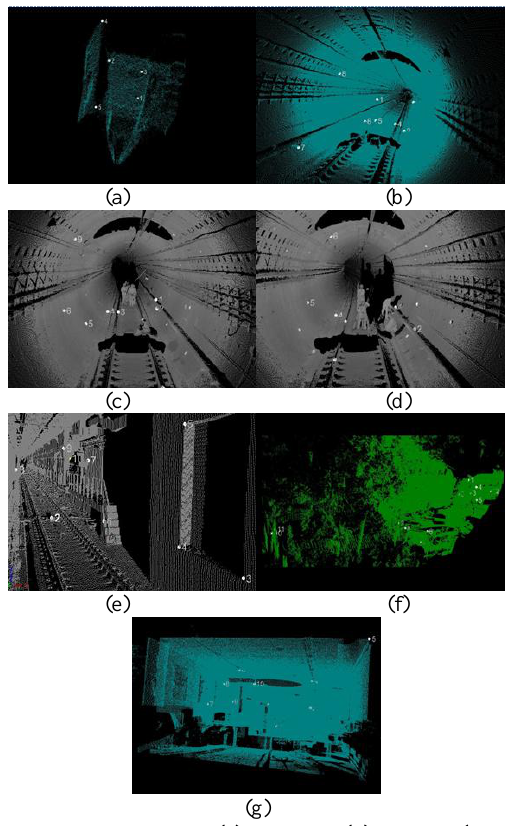
Figure 3. Check points. (a) Dataset 1; (b) Dataset 2(Point cloud I~II); (c) Dataset 2 (Point cloud II-III); (d) Dataset 2 (Point cloud III-IV); (e) Dataset 2 (Point cloud pair V-VI); (f) Dataset 3; (g) Dataset 4.